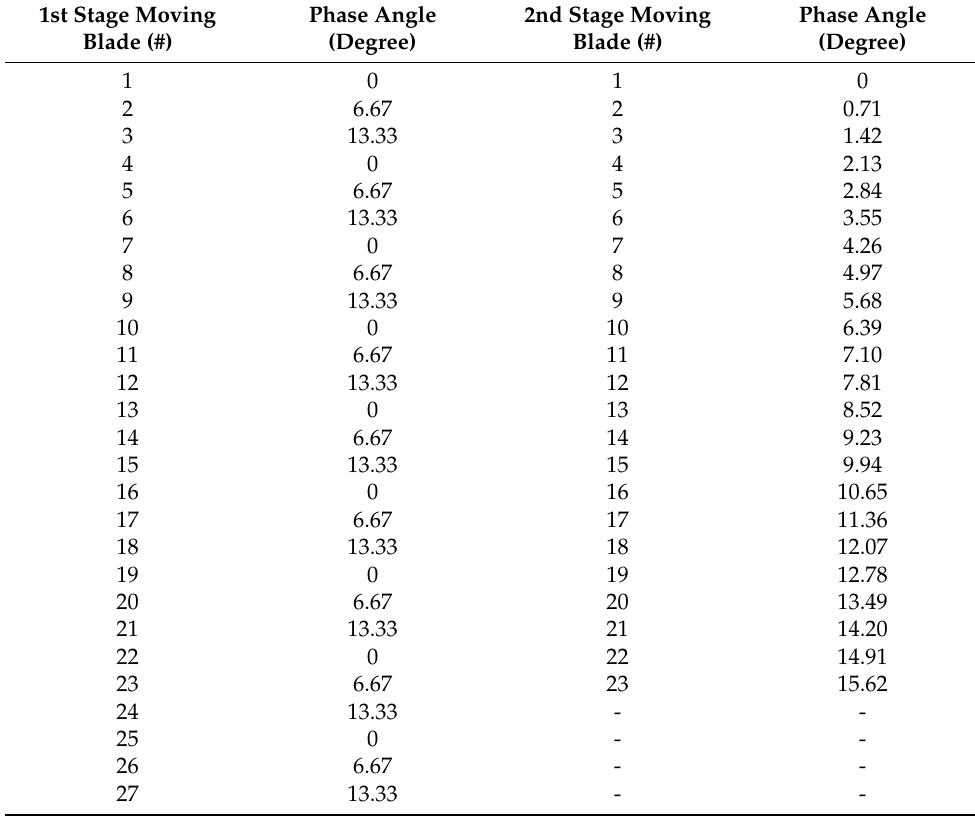
Figure 18. The phase difference of the 2nd stage moving blade. Table 5. The phase difference of aerodynamic action of moving